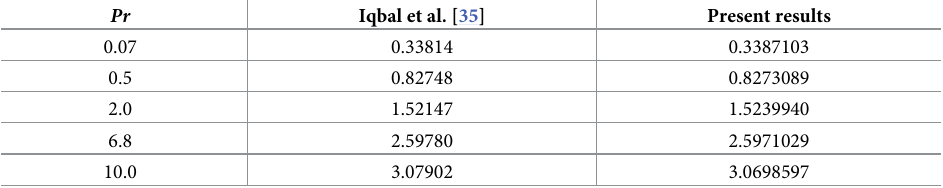
Table 3. Comparison of simulations in view of Nusselt number when ϕ 1 =0, ϕ 2 = 0, A = 3.0, β = 1. Pr Iqbal et al.